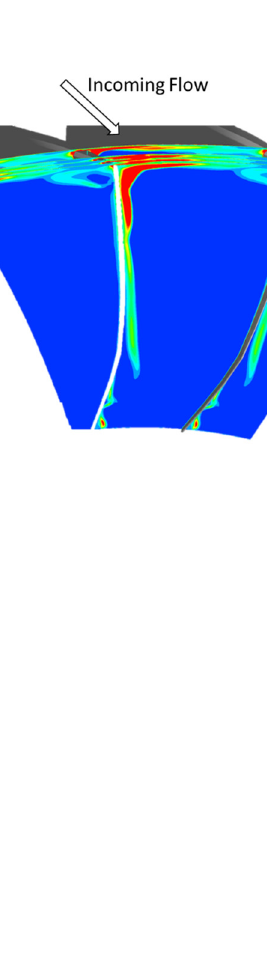
Figure 14. Magnified view of EGR contours on the two intersecting surfaces.